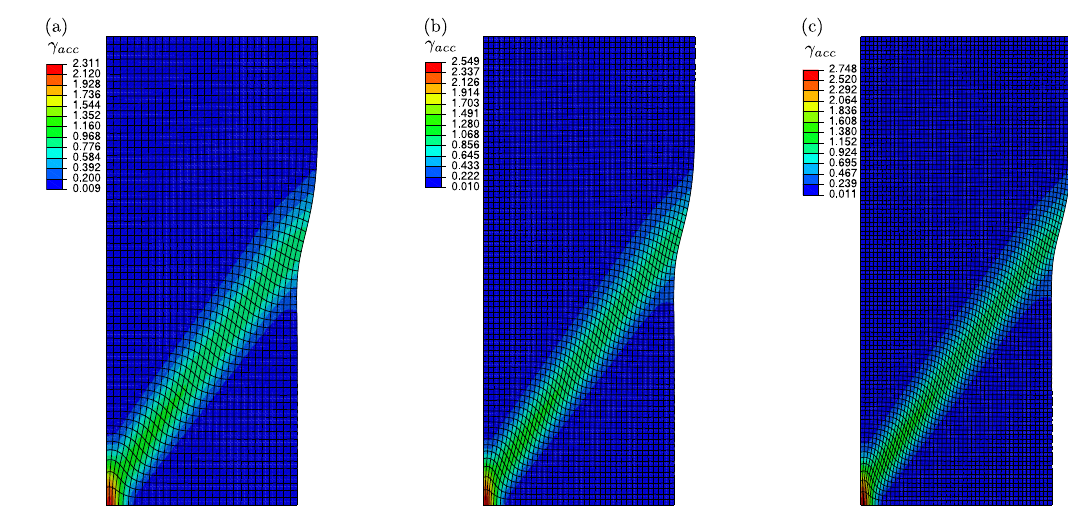
Figure 10. Deformed meshes and contours of accumulated plastic slip variable γ acc at nominal strain ∆ L / L 0 = 0.1 for different mesh refinements ( a ) mesh 30 × 60 ( b ) mesh 40 × 80 and ( c ) mesh 50 × 100 ( l en / W = 0.2, l dis = 0, H π = − 500